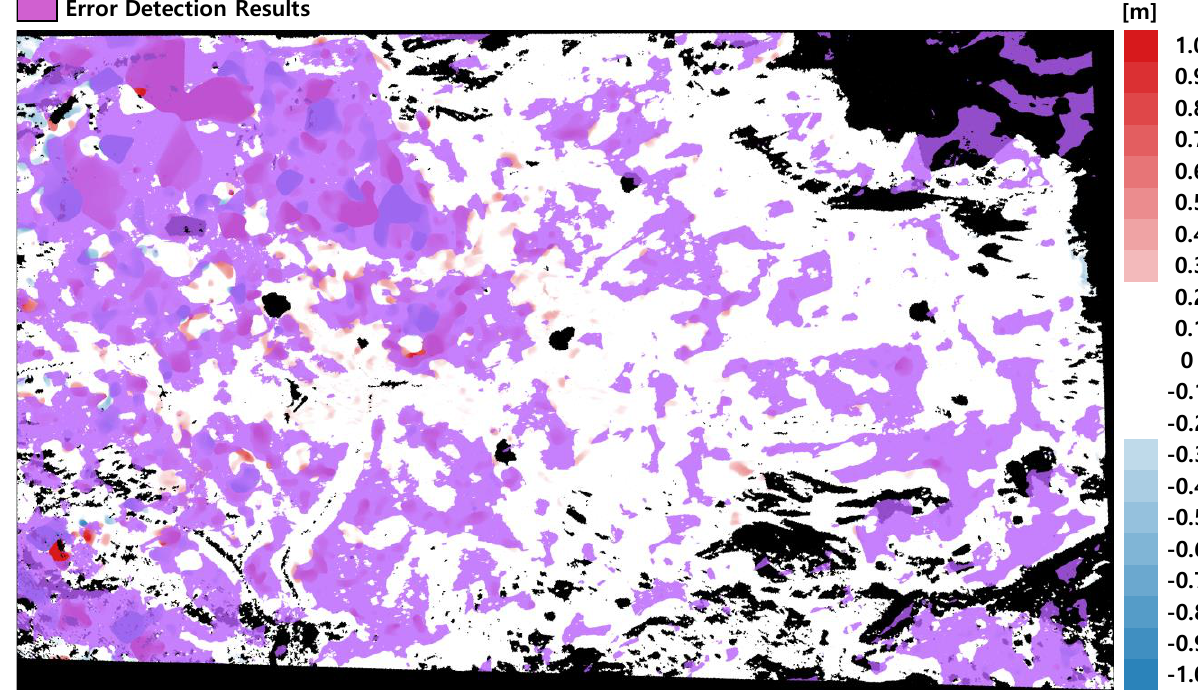
Error Detection